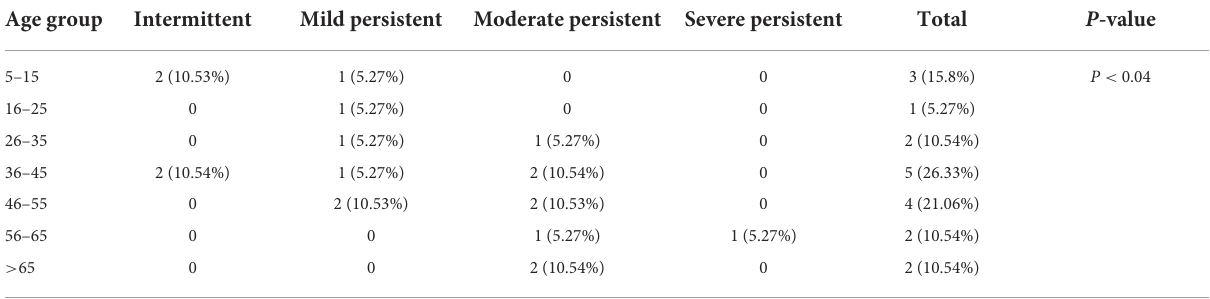
TABLE 2 Severity of asthma manifestations according to different age groups in individuals with positive Toxocara serology.